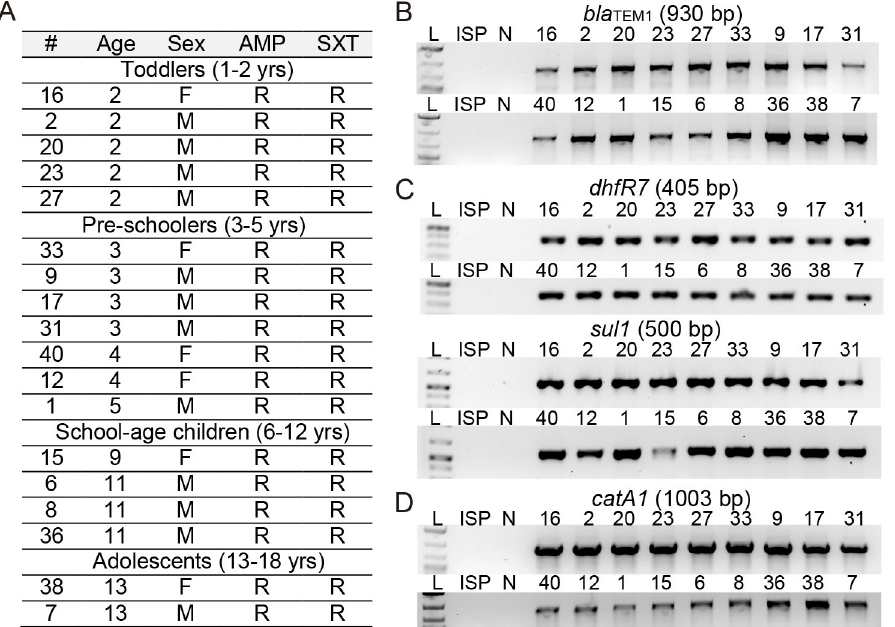
Fig 2. Molecular basis of resistance to first-line antibiotics among XDR S . Typhi isolates. A , Sample information and antibiotic resistance profiles of select of XDR S . Typhi isolates for molecular characterization. See S3 Table for details. B , PCR reactions for bla TEM1 . C , PCR reactions for dhfR7 and sul1 . D , PCR reactions for catA1 . ISP, antibiotic- susceptible S . Typhi ISP2825. N, negative control containing all PCR components except for S . Typhi genomic DNA. See S4 Table for